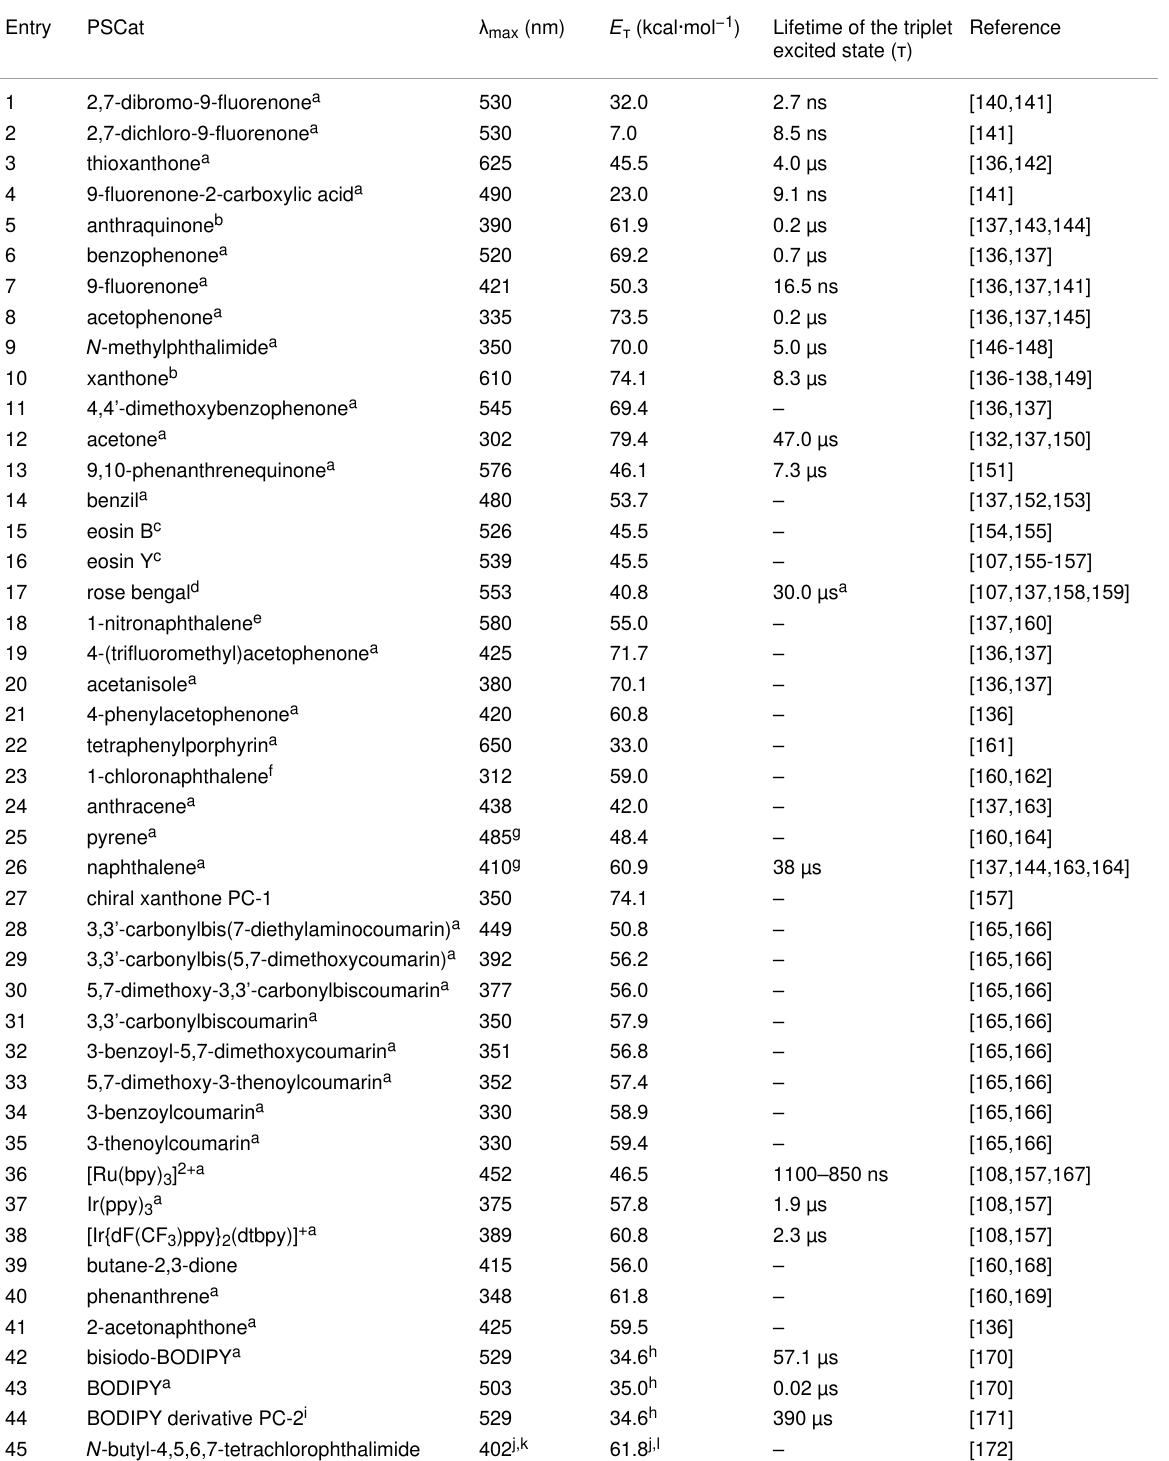
Table 1: Absorption maxima, triplet energies and lifetimes of common